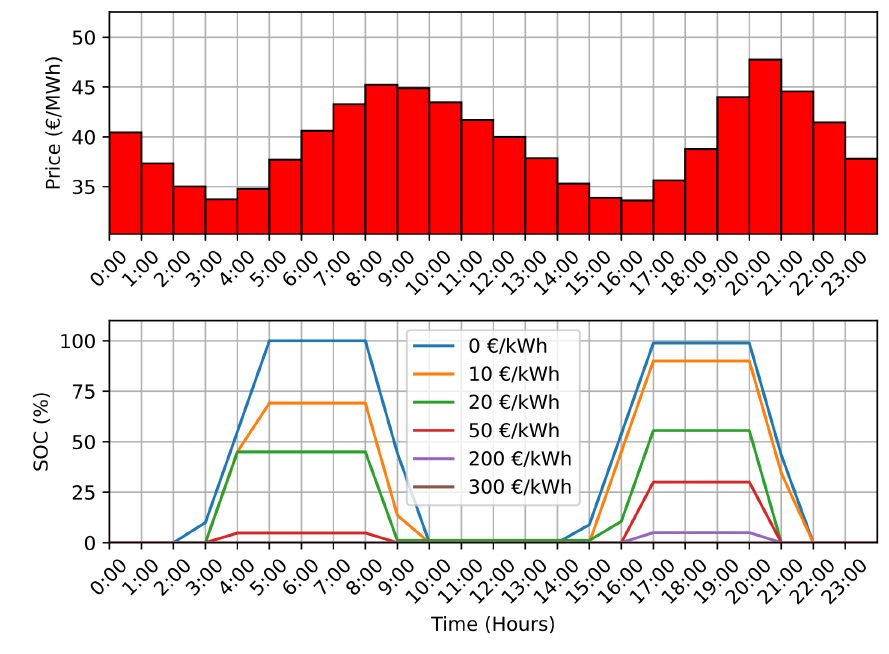
Figure 3. Daily operation results for different capital